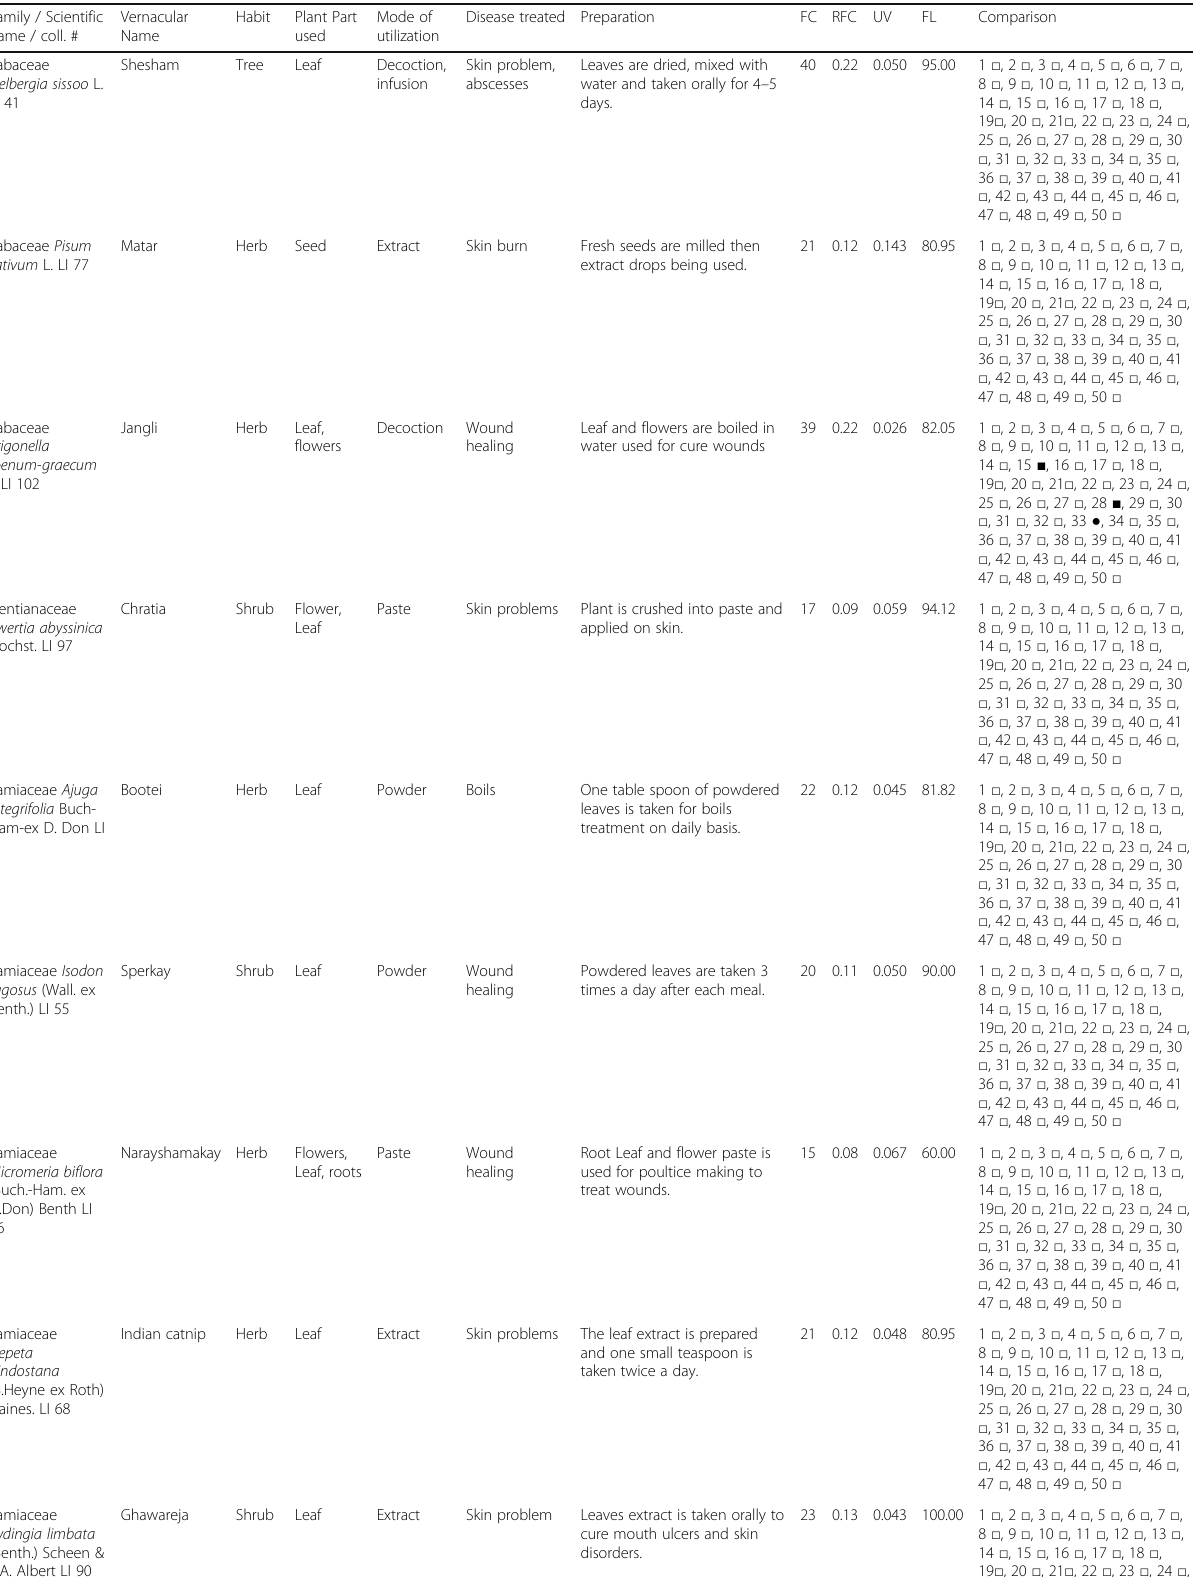
Table 2 Medicinal plants used for skin diseases in Northern Pakistan (Continued) Family / Scientific name / coll.